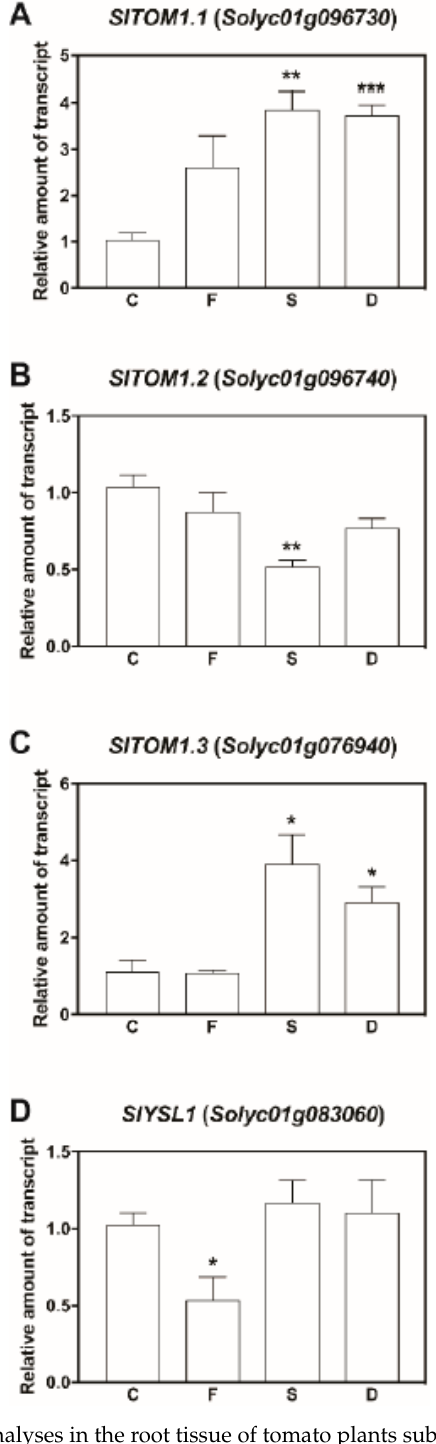
Figure 7. Gene expression analyses in the root tissue of tomato plants subjected to di ff erent nutritional regimes. The levels of expression of SlTOM1.1 ( A ), SlTOM1.2 ( B ), SlTOM1.3 ( C ) and SlYSL1 ( D ) were assessed by quantitative Real Time RT–PCR. The data were normalised to two internal controls: Tomato LeEF-1 mRNA for elongation factor 1 alpha and Tomato ubi3 gene for ubiquitin. The relative expression ratios were calculated using C plants as a calibrator sample. The values reported are means ± SE ( n = 3). The statistical significance was tested by means Student (cid:48) s t test (*, p < 0.05; **, p < 0.01; ***, p <